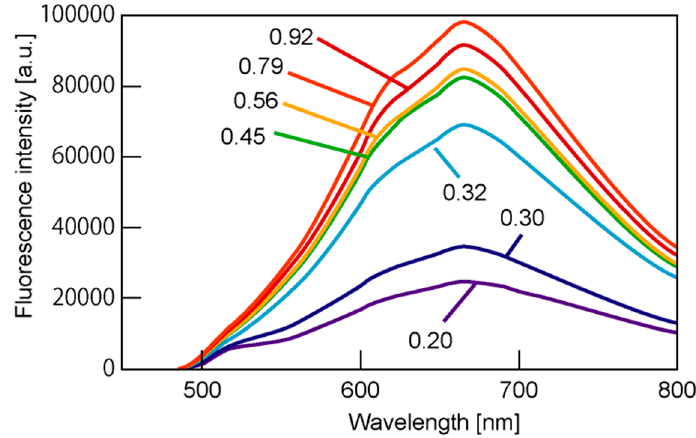
Figure 8. Emission spectra of L-Cys/Au(I)@CD-MOF with various introduction amounts of the L-Cys/Au(I) complex. The numerical values indicate the number of L-Cys/Au(I) complexes per ( γ -CD) 6 unit.